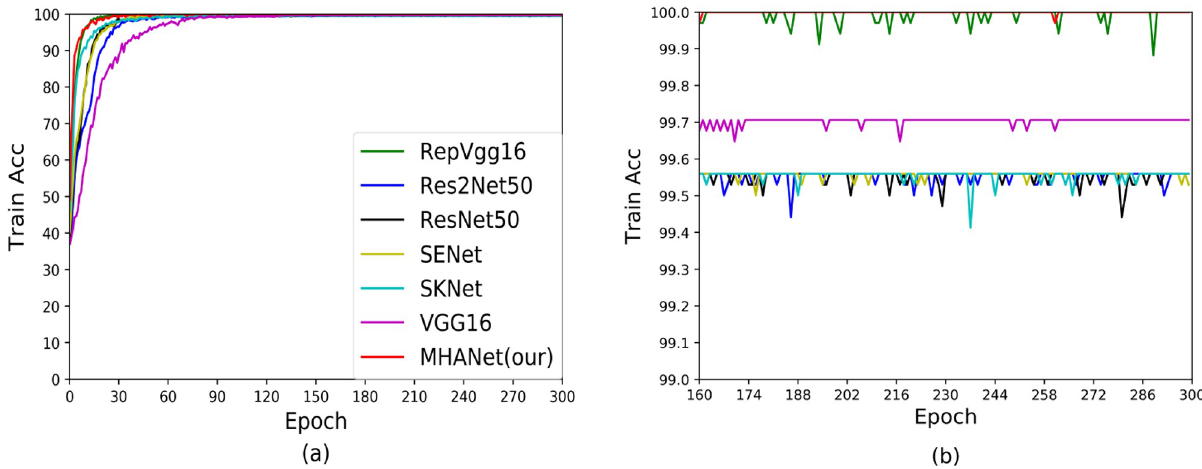
Fig 5. Training accuracy curves of Dataset1.